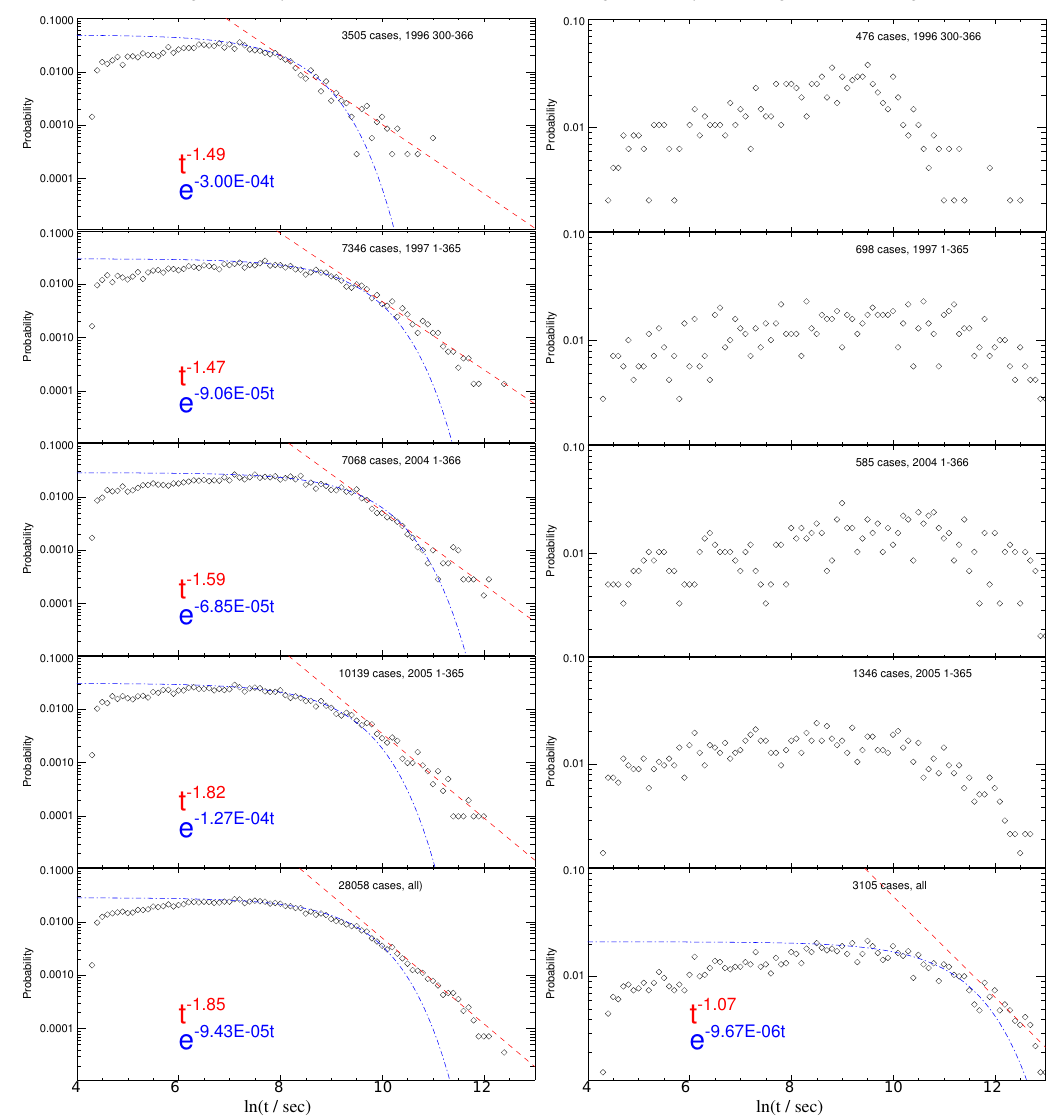
Fig. 9. Waiting time analysis in different years. The left side is the waiting time analysis on the current sheets with all deflection angle; the right side is the waiting time analysis on the current sheets with only large deflection angle ( 1θ ≥ 72 ◦ ). From top to the bottom, the first panel is the waiting time analysis from DOY 300 to DOY 366 in 1996; the 2nd, 3rd, and 4th panels are the waiting time analysis in 1997, 2004, and 2005, respectively. The bottom panel is the waiting time analysis for all current sheet cases. The y-axis is the logarithm of the probability of current sheet occurrences and the x-axis is the logarithm of waiting time, ln (t/ sec )